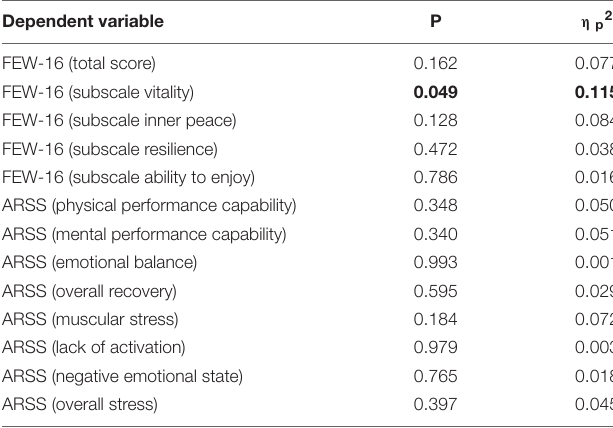
TABLE 1 | Interaction relationships for Group (CG, OPR − , OPR + , OPR ++ ) and Time (T1, T2) as predictors of the subscales in the FEW-16 and